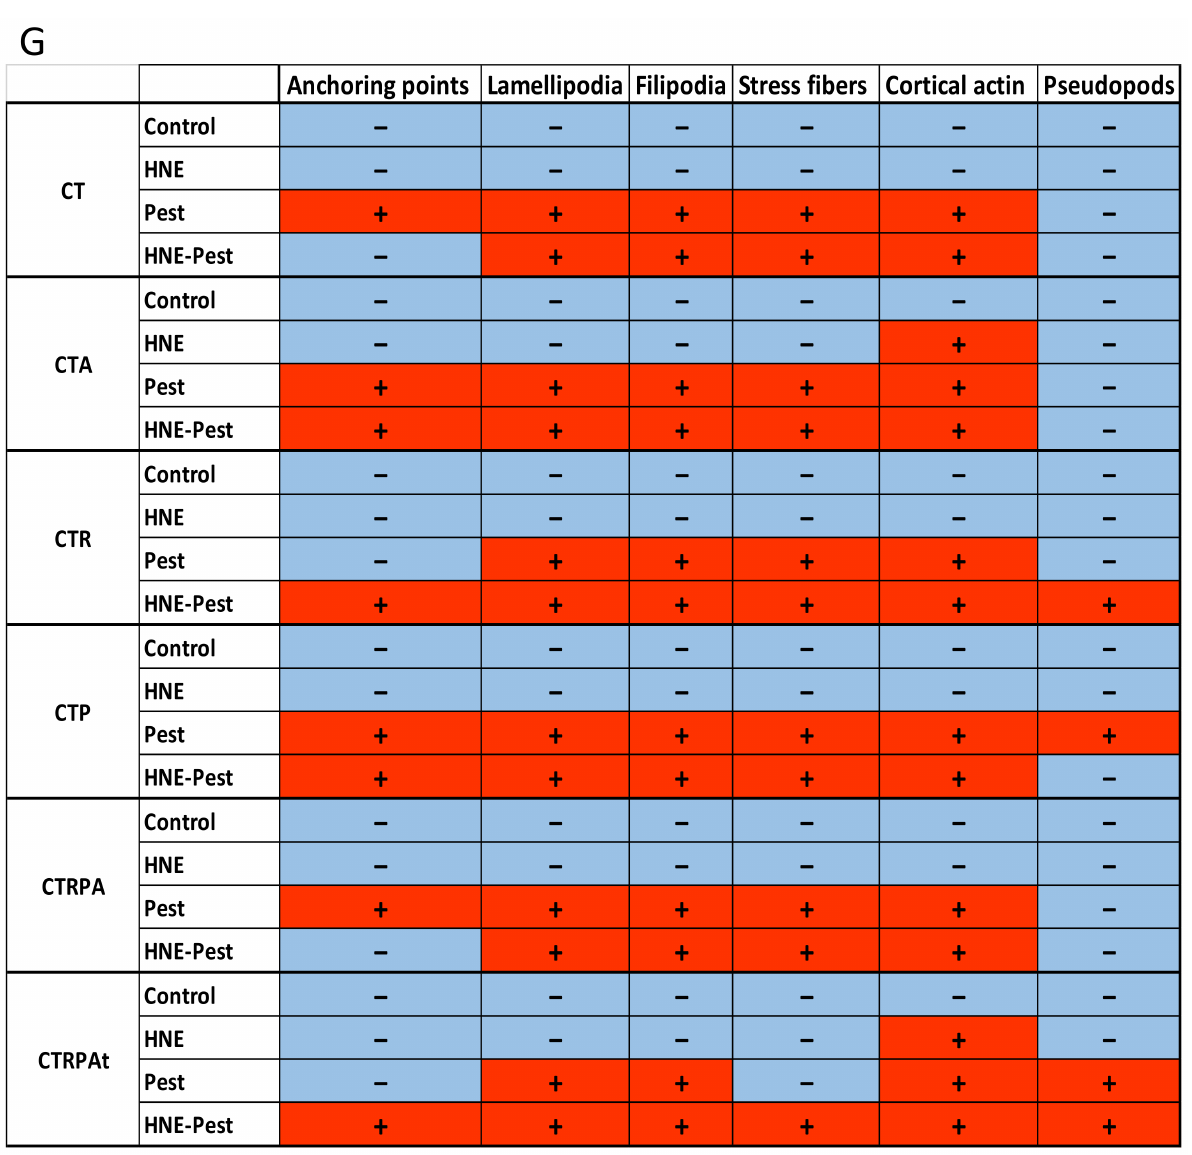
Figure 5. Cell morphology after three weeks exposure to contaminants in HCECs. Representative images of Actin (red), Paxillin (green) immunostaining in the six HCECs, showing the colocalization of Actin and Paxillin (MERGE, yellow). DNA was stained with DAPI (blue). Scale bar = 10 µ m. ( A ) CT cells: for pesticide condition, white arrows indicate filipodia, stress fibers and lamellipodia; for HNE-Pest condition white arrows indicate cortical actin and filipodia. ( B ) CTA cells: for pesticide condition, white arrows indicate stress fibers and anchoring points; for HNE-Pest condition arrows indicate filipodia. ( C ) CTR cells, ( D ) CTP cells, ( E ) CTRPA cells and ( F ) CTRPAt cells. ( G ) Summarized table of analysed moving cells parameters after long-term exposure of